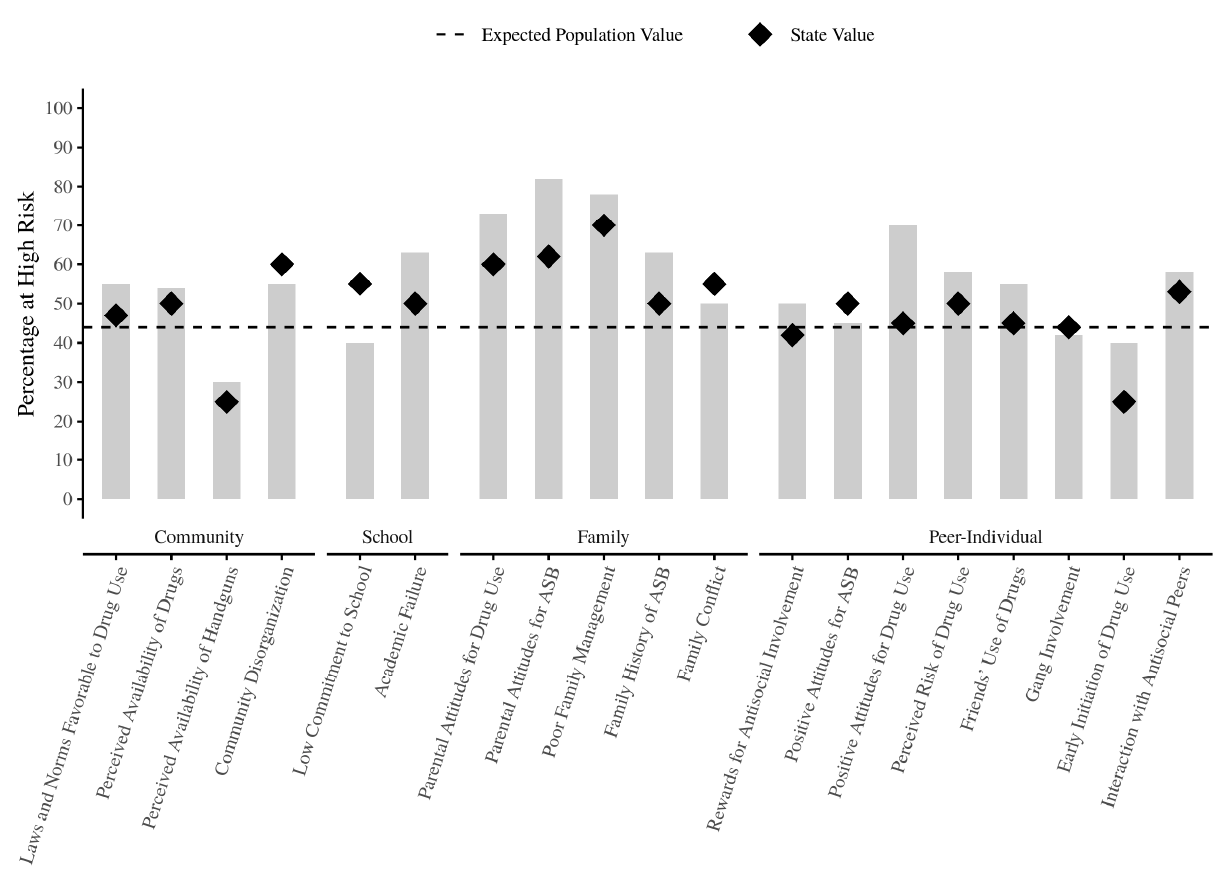
Figure 1. Risk Factor Profile for a School.